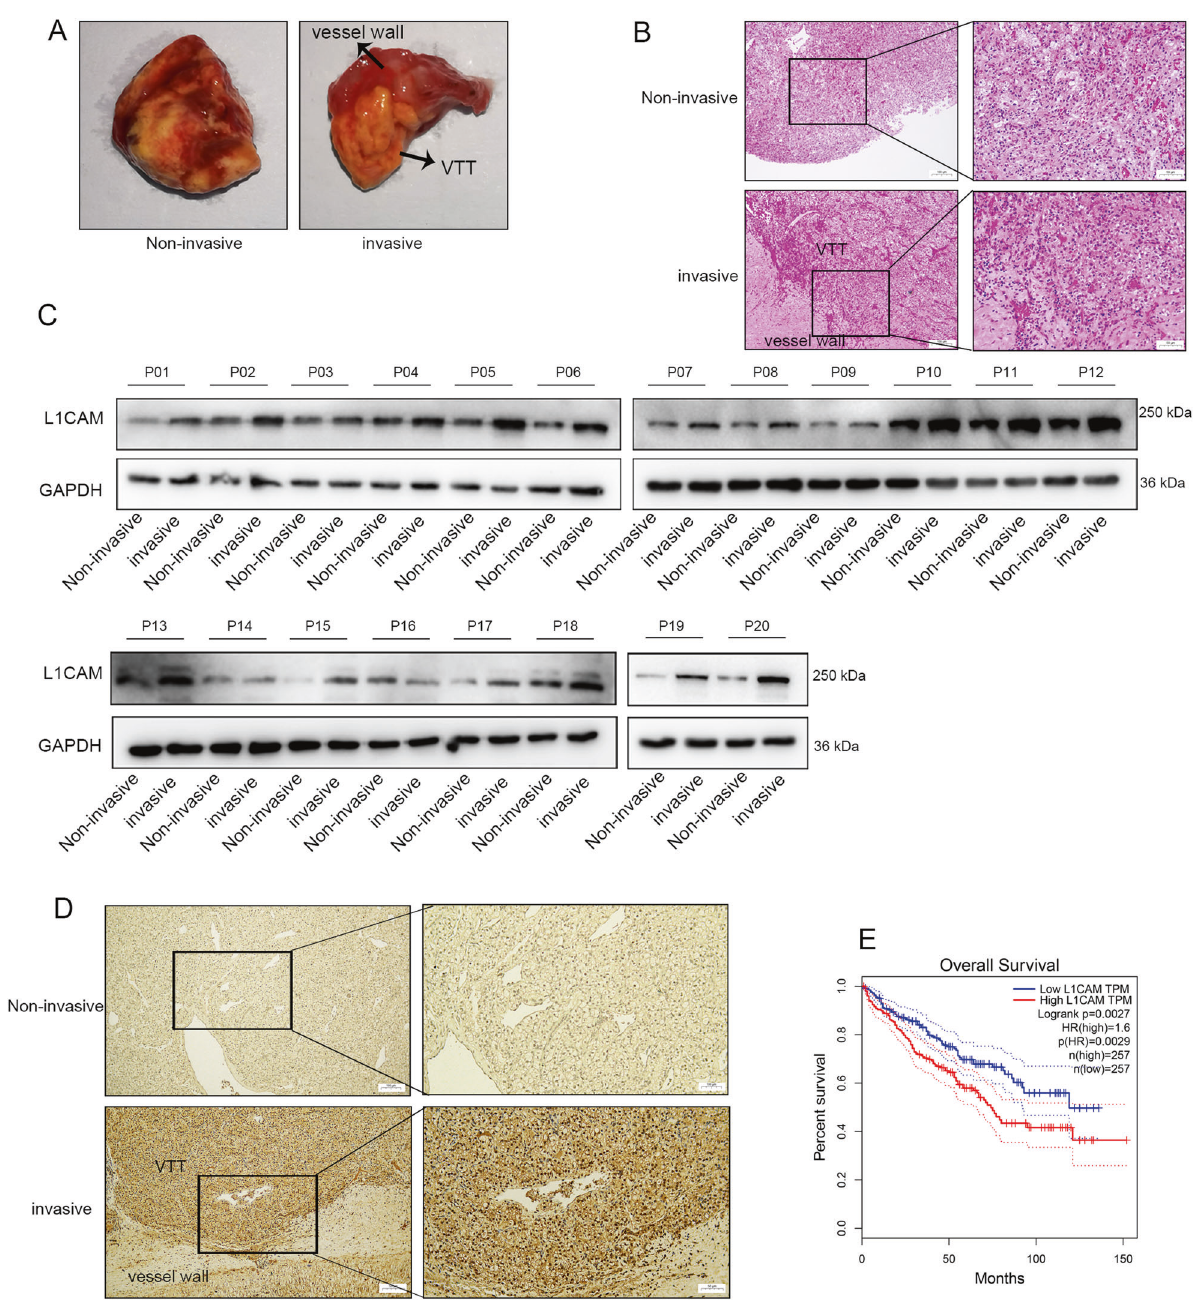
wall. B H&E staining of VTT specimens. VTT venous tumor thrombus. C L1CAM protein expression in 20 pairs of VTT tissue samples. P patient. D Representative images of IHC staining of L1CAM in noninvasive and invasive VTT tissue adjacent to the vessel wall sample (40× and 200× magni fi cations). E Survival analysis of TCGA data using GEPIA online